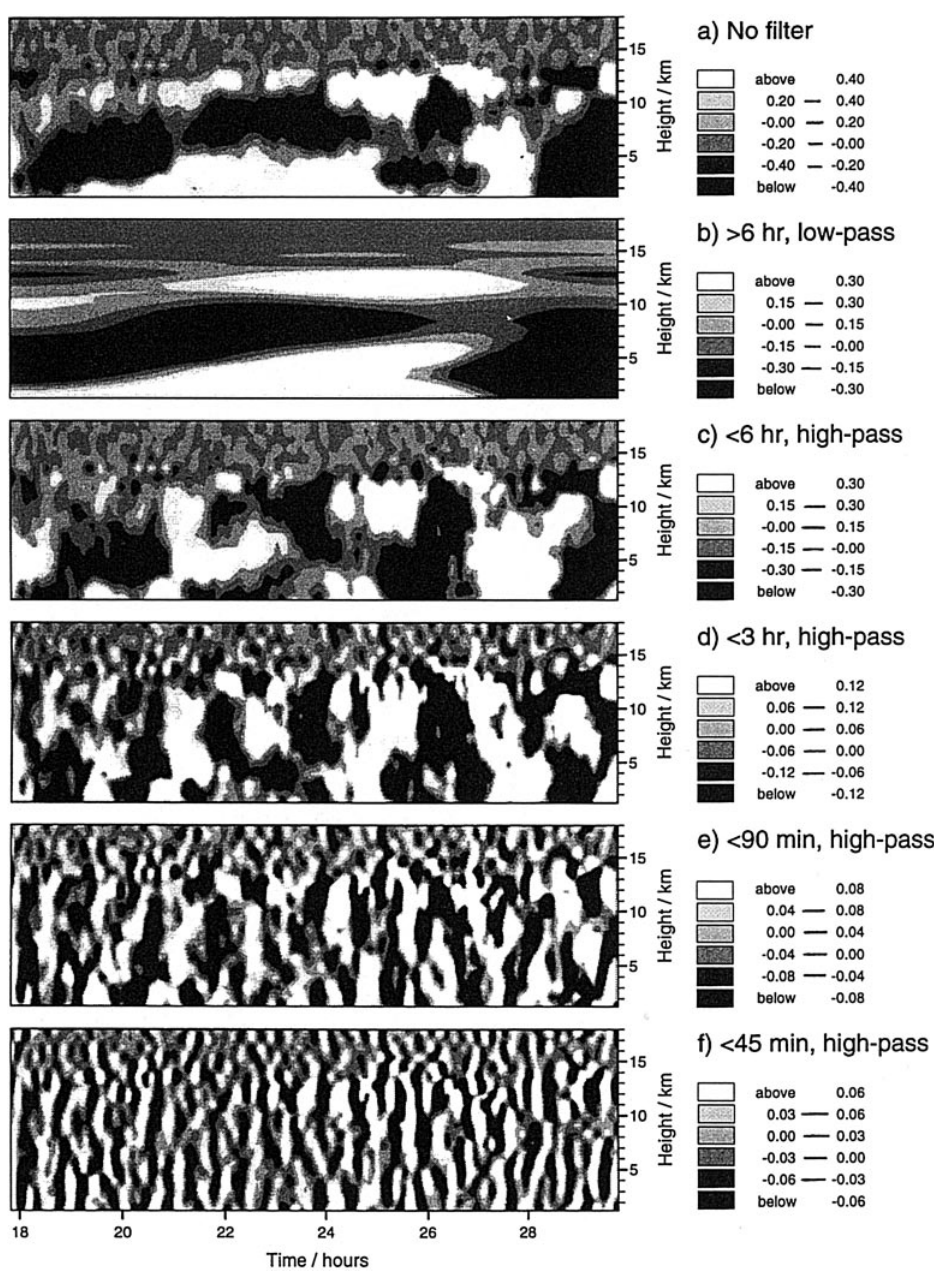
Fig. 8a–f. Height–time contour plots of velocity measured in the vertical beam with the Aberyst- wyth VHF radar, original and filtered time series (from Worthington and Thomas, 1998, Copyright Royal